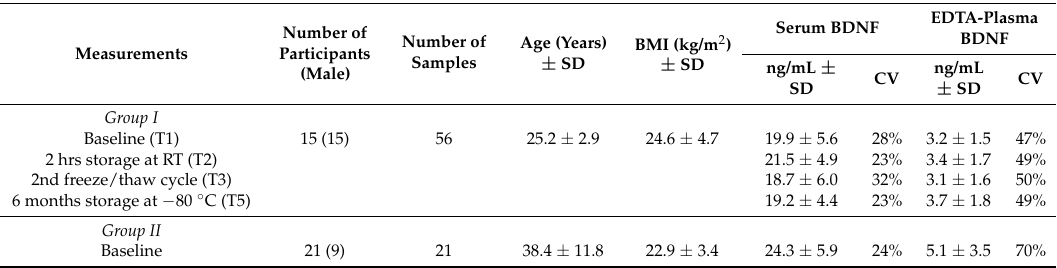
Figure 1. Schematic design of the stability study. T1 to T5 represent time points for BDNF measurements. Blue crosses signify freezing at − 80 °C. The grey box at T4 indicates the time point which was excluded from the analysis due to a measurement error. BDNF: brain-derived neurotrophic factor, EDTA: ethylenediaminetetraacetic acid, ELISA: enzyme-linked immunosorbent assay, hrs: hours, min: minutes, rpm: rounds per minute, T: time point. Table 1. Anthropometric data of participants and respective BDNF concentrations in serum and EDTA-plasma.